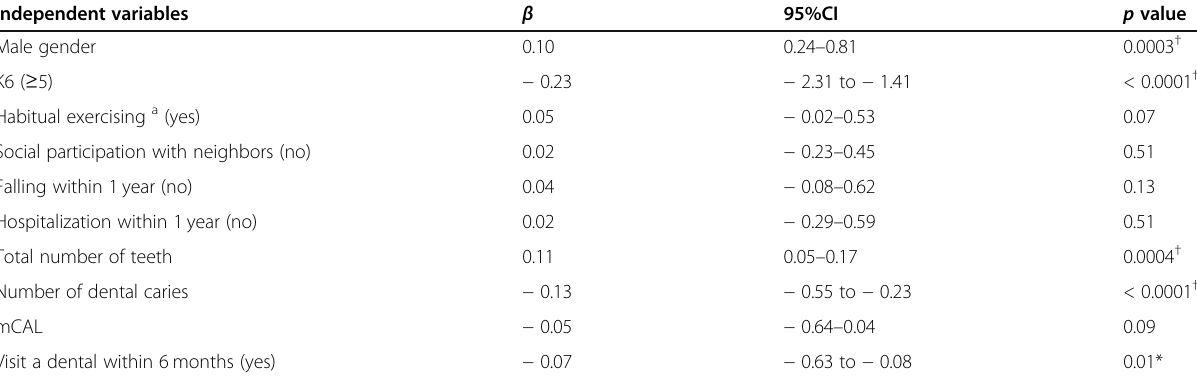
Table 3 Multiple regression analysis to determine the factors identifying GOHAI Independent